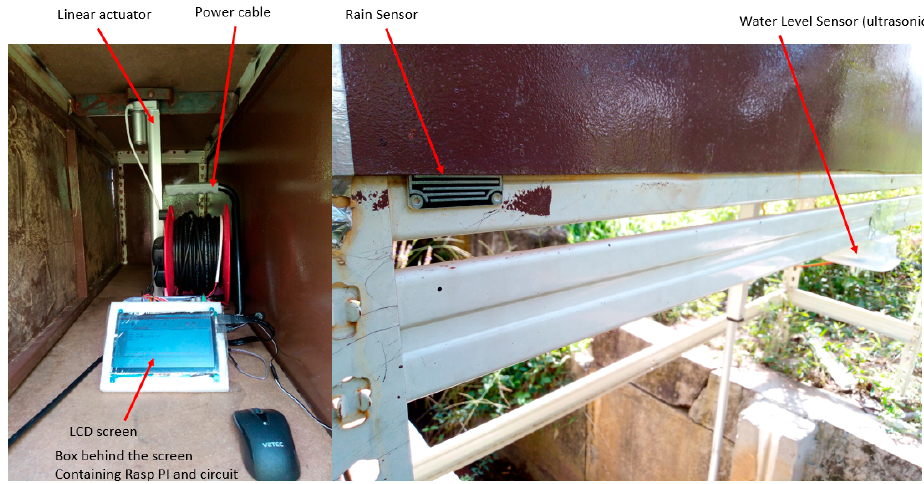
Figure 7. Gate V3 hardware components.